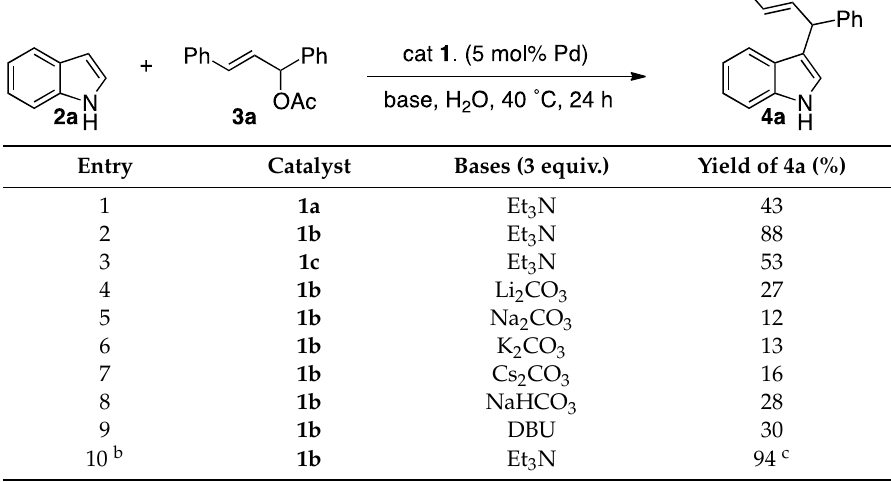
Table 1. Friedel–Crafts-type alkylation of indole in water using catalysts 1 and several bases a .